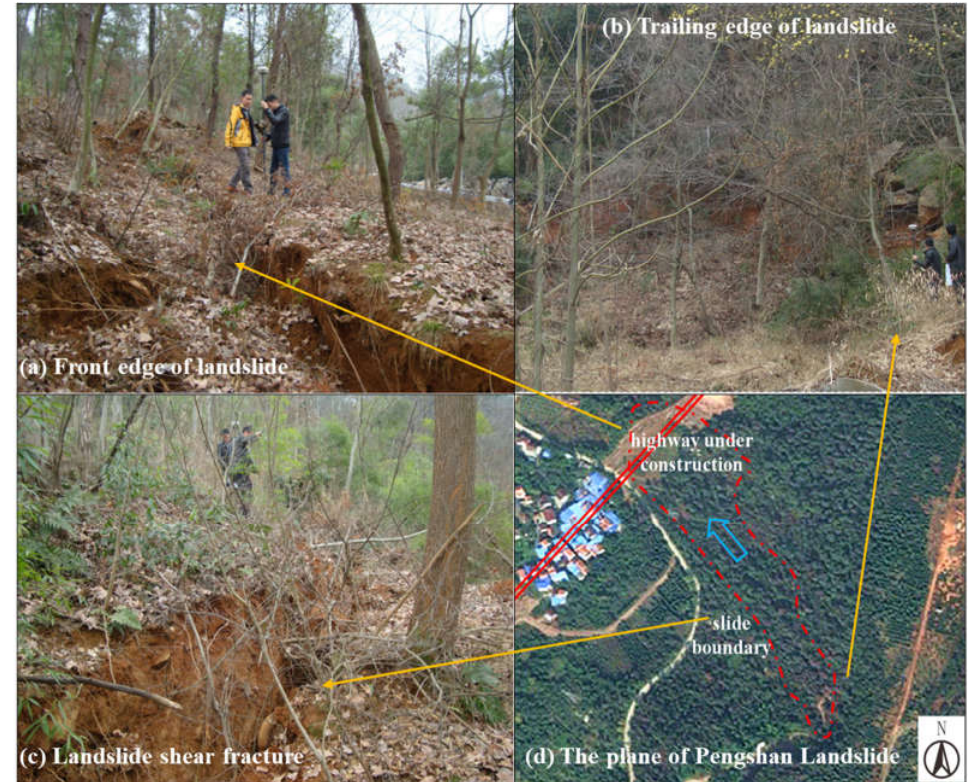
Figure 2. Landform characteristics of landslide: ( a ) front edge of landslide; ( b ) trailing edge of landslide; ( c ) landslide shear fracture; ( d ) the plane of Pengshan Landslide.